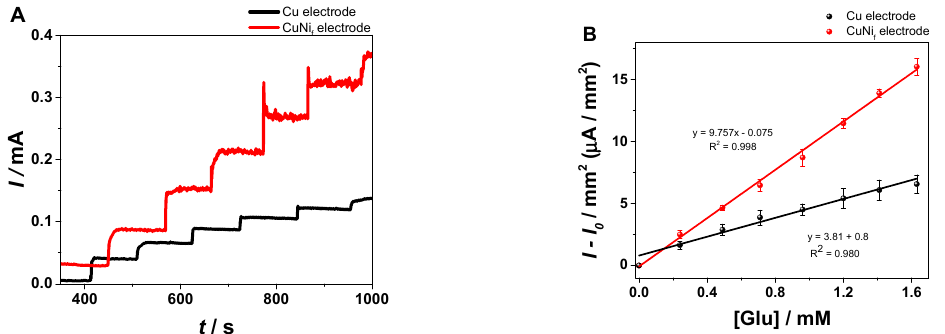
Figure 8. ( A ) CA on Cu strip electrodes (black line) and Cu / Ni f on Cu substrate electrodes (red line) in 5 mL 0.1 M NaOH with standard additions of 25 mM Glu every 100 s (50 µ L under continuous stirring at 500 rpm) (0.55 V, 0.1 step potential, 1200 s analysis time, 500 rpm). ( B ) The corresponding calibration curves for the Cu bare electrode (black line) and Cu / Ni f on Cu electrode (red line).